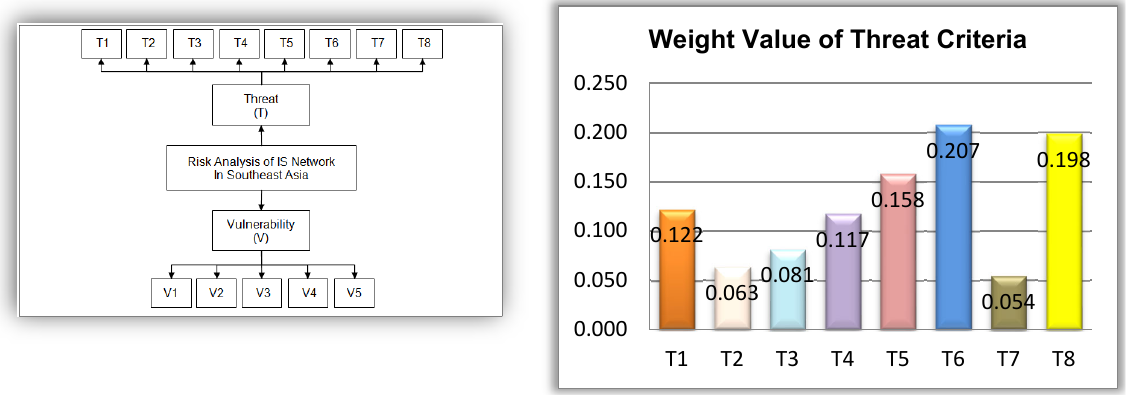
Fig. 1. Risk Analysis Structure of Islamic State Network Fig. 2. Graphical Analysis of Threat Criteria